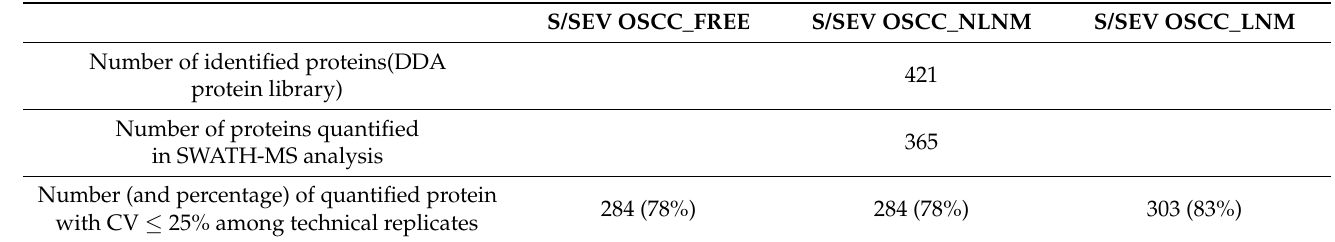
Table 3. Summary of proteome analysis.